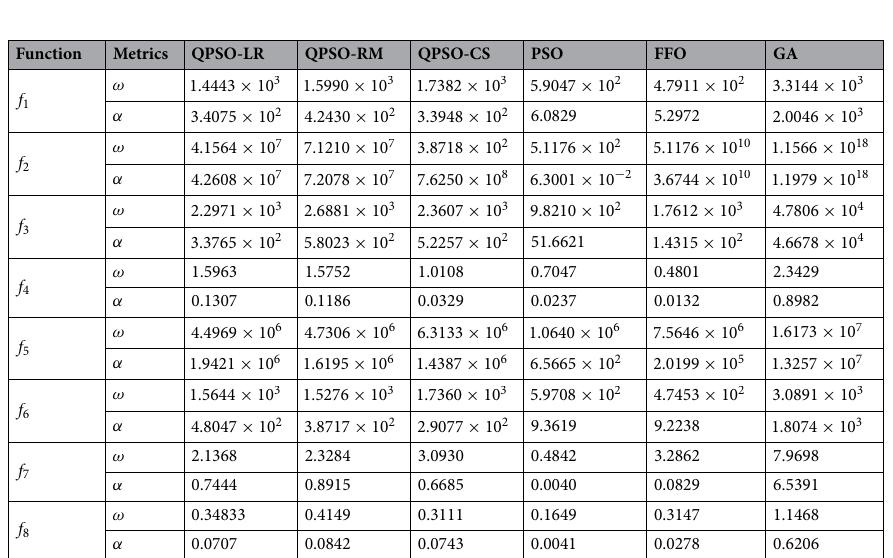
Table 4. Convergence speed and acceleration metrics for unimodal benchmark functions with N = 30, Tmax = 1000 and Texp = 30.